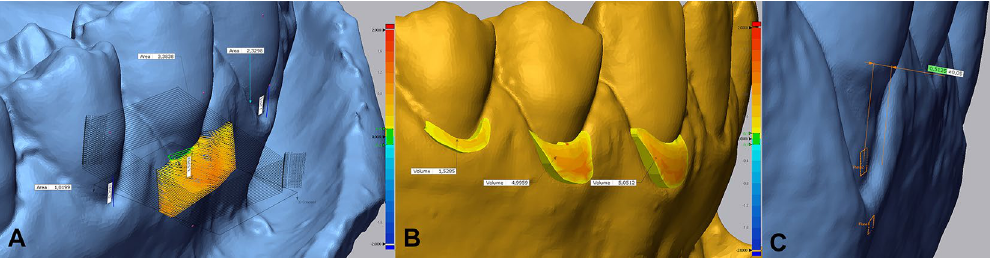
Figure 3. ( A ) Insertion of section plans perpendicular to ROI’s entire length. ( B ) The volume of tissue over the denuded root obtained after connective tissue graft between T0 (baseline) and T2 (6 months). ( C ) Two planes are defined, and the distance between them is automatically